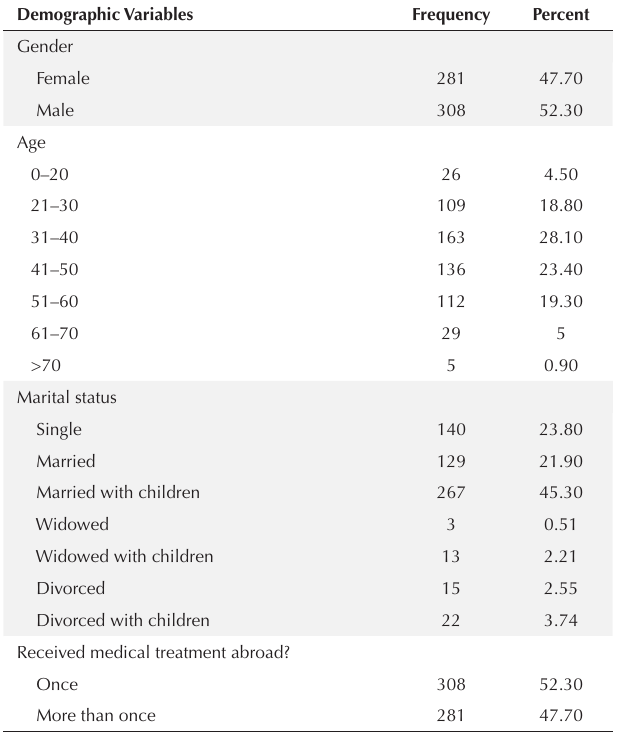
Table 3. Descriptive Statistics for the Study Sample Demographic Variables